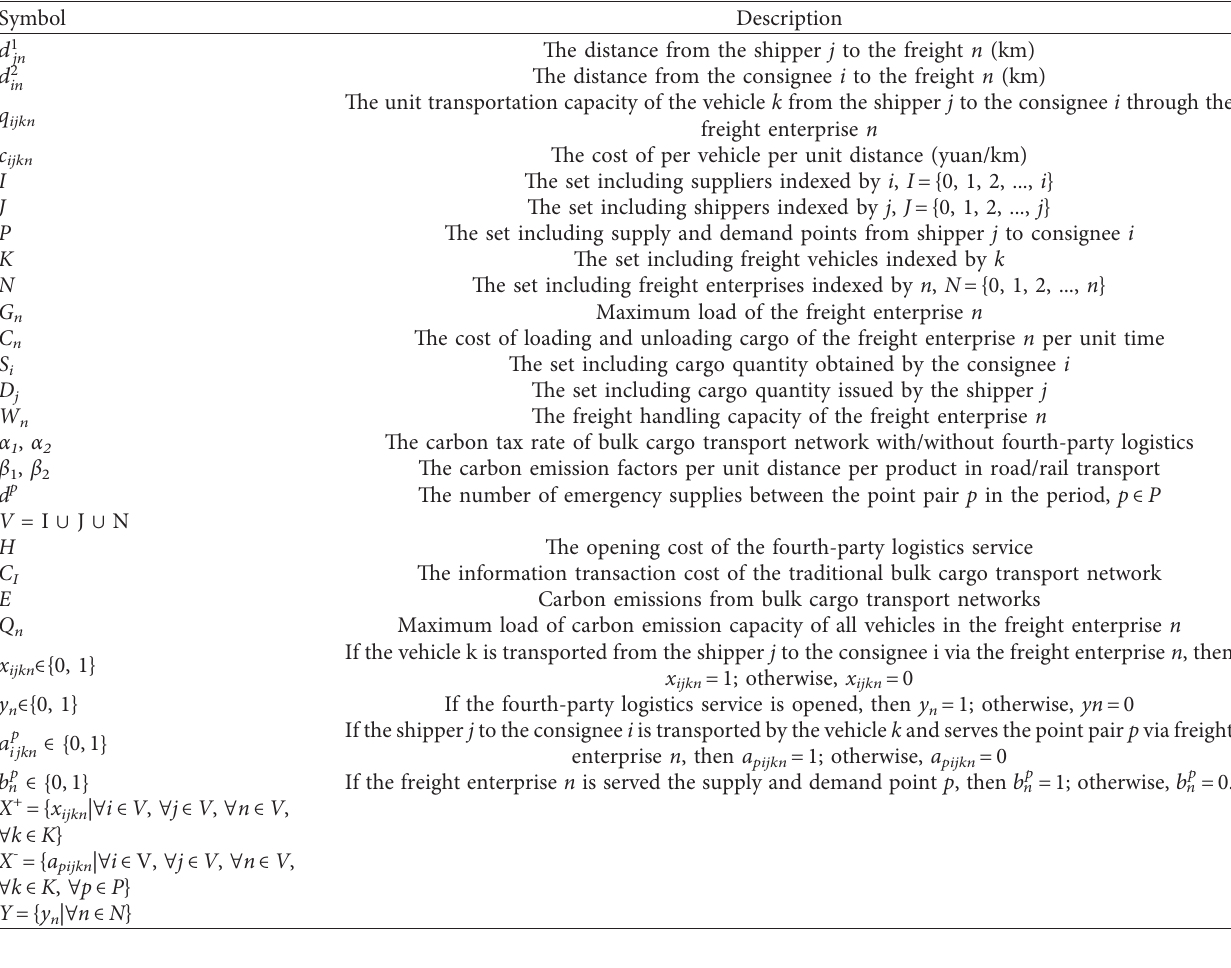
Table 1: Parameters, sets, and decision